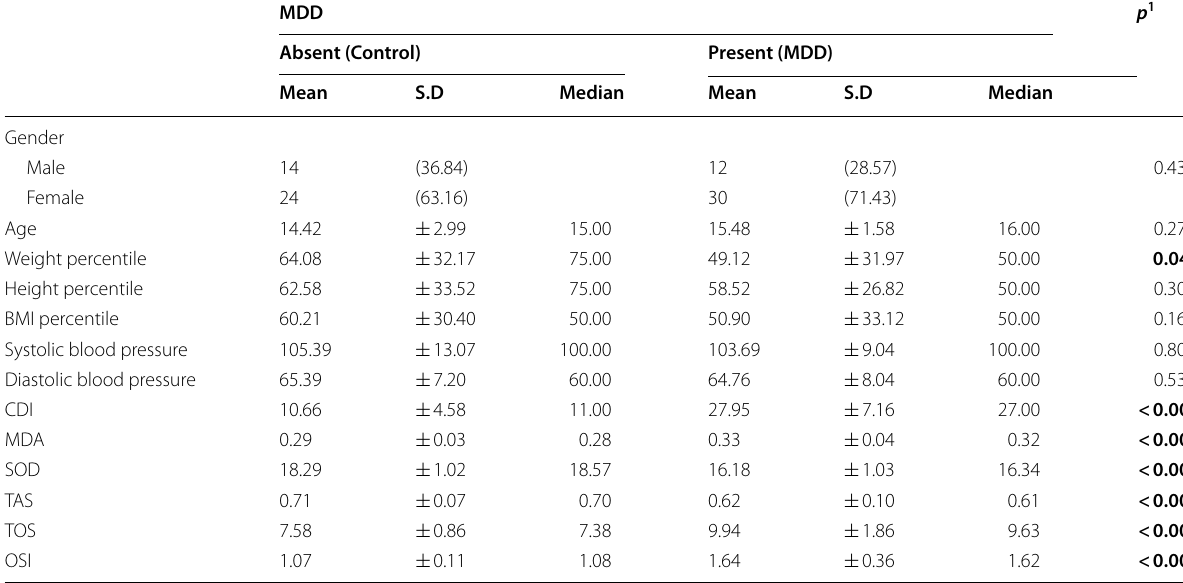
Bold indicates p -value